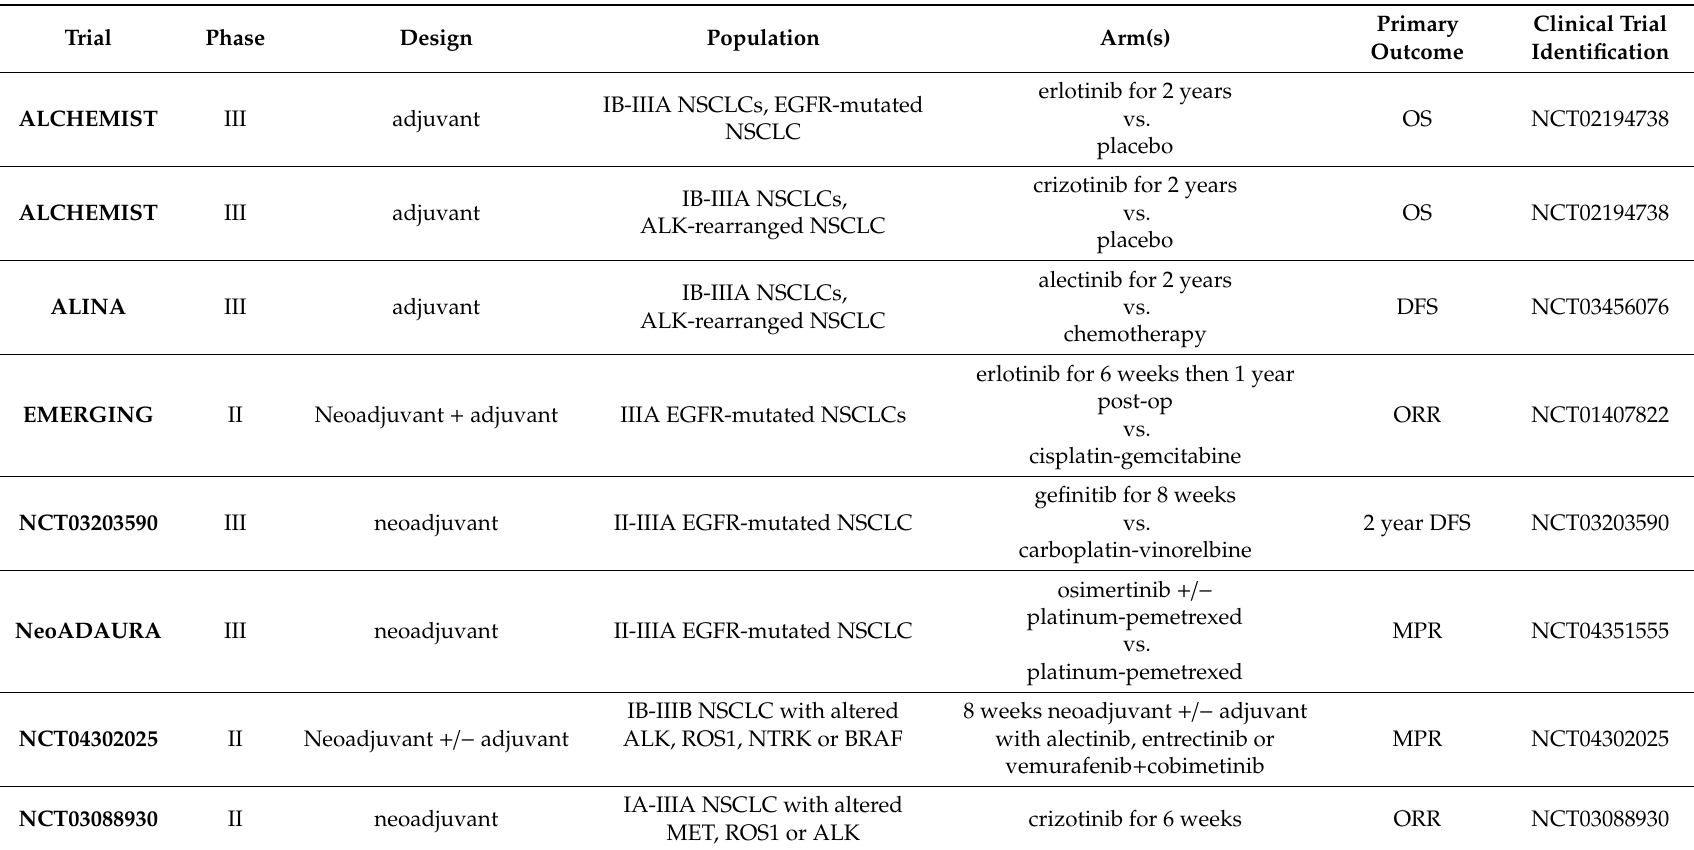
Table 2. Ongoing phase II–III neoadjuvant and adjuvant trials with tyrosine kinase inhibitors